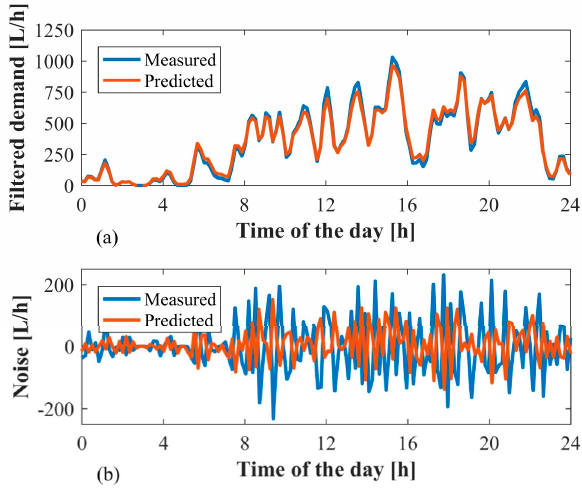
Figure 5. Comparison of the predicted and the measured components for ( a ) the filtered demand and ( b ) the noise for a selected day.